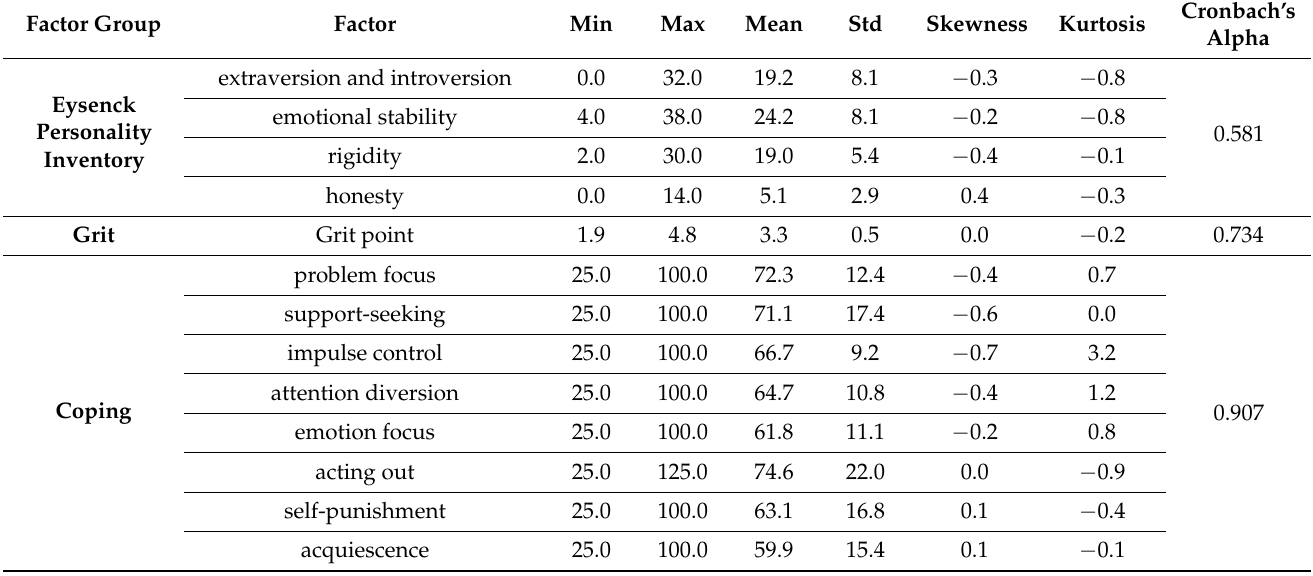
Table 1. Descriptive statistics and psychometric attributes of the set of measured variables. Factor